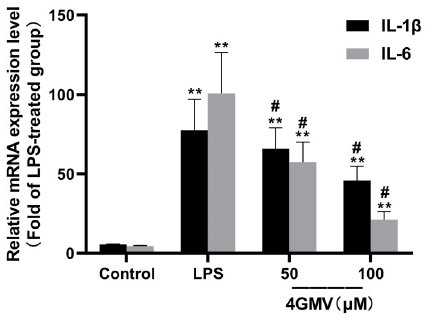
Figure 7. Effect of 4 ’ -O- b -D-glucosyl-5-O-methylvisamminol (4GMV) on lipopolysaccharide (LPS)-induced mRNA expression of IL-6 and IL-1 b in RAW 264.7 cells. RAW 264.7 cells were pretreated with 4GMV (50 and 100 m M) for 1 h prior to treatment with 1 m g/mL LPS. After 24 h, the expression of levels of interleukin (IL)-1 b and IL-6 mRNA were measured by RT-PCR analysis. Data are reported as means ± SD (n=3) of three independent experiments. **P o 0.01 compared with the control group; # P o 0.05 compared with the LPS group (ANOVA followed by LSD).